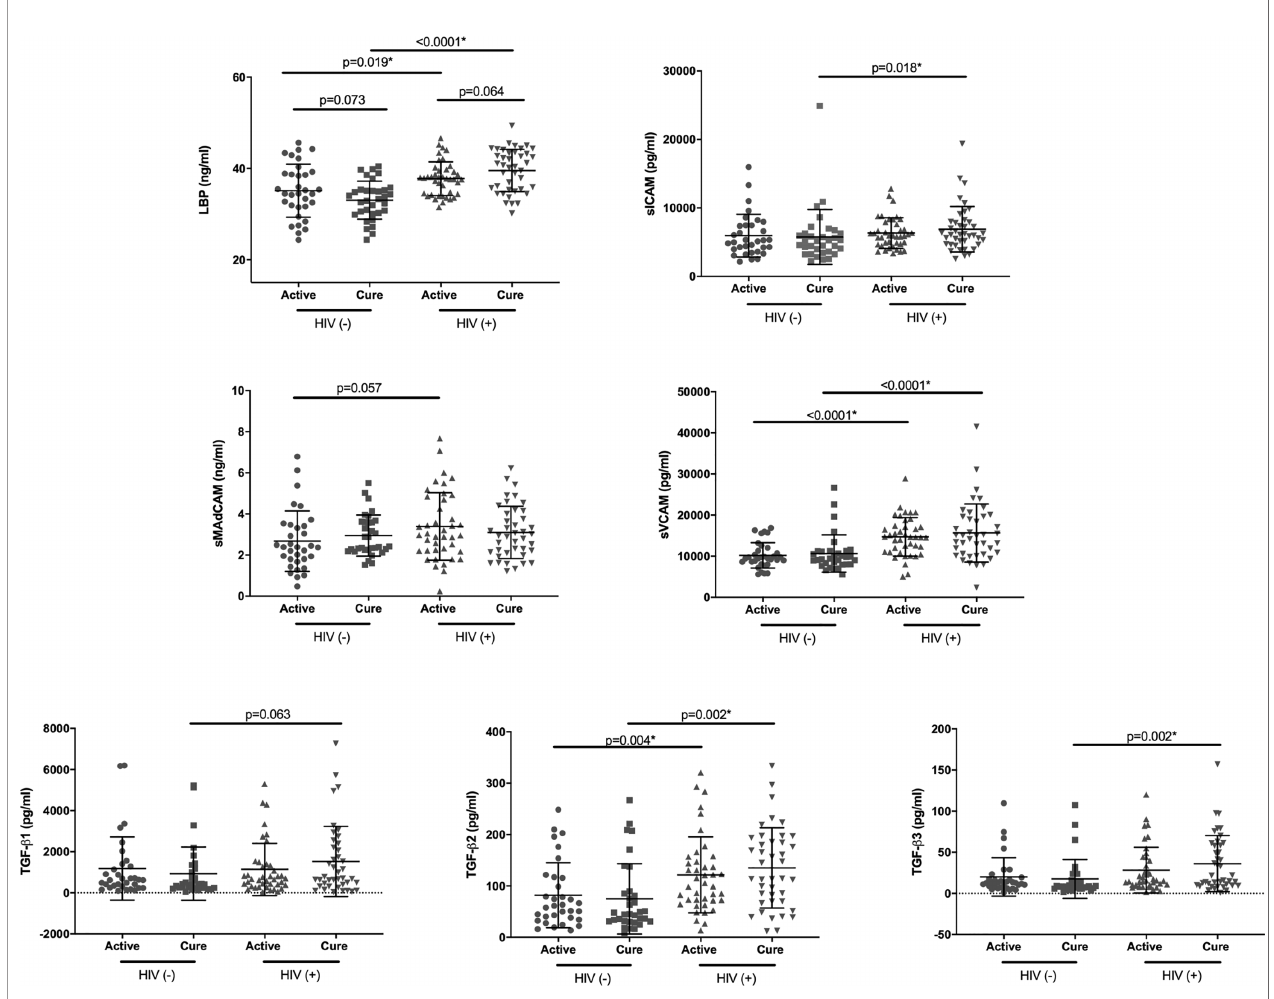
FIGURE 2 | Plasma levels of LBP, sMAdCAM, sICAM, sVCAM, TGF- b 1, TGF- b 2 and TGF- b 3 in HIV uninfected [HIV(-)] and HIV infected [HIV(+)] IMPRESS participants at active TB (active) and post- TB treatment (cure) timepoints. Based on the result of the normality test either parametric: paired t-test (Active vs Cure) and t-test (HIV+ vs HIV-), or non-parametric: Wilcoxon signed rank (Active vs Cure) and Mann-Whitney (HIV+ vs HIV-) tests were used for the analysis. *Statistically signi fi cant association after FDR adjustment using 0.05